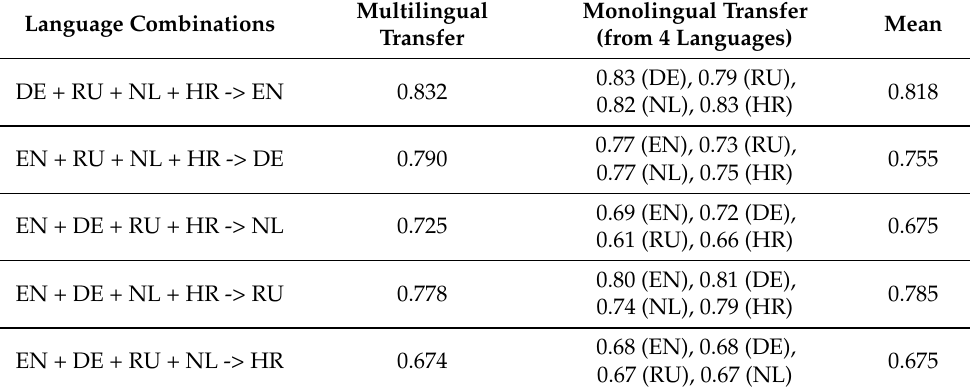
Table 5. Spearman’s correlation coefficient for the MS-MiniLM model (1000-word dictionaries). Language